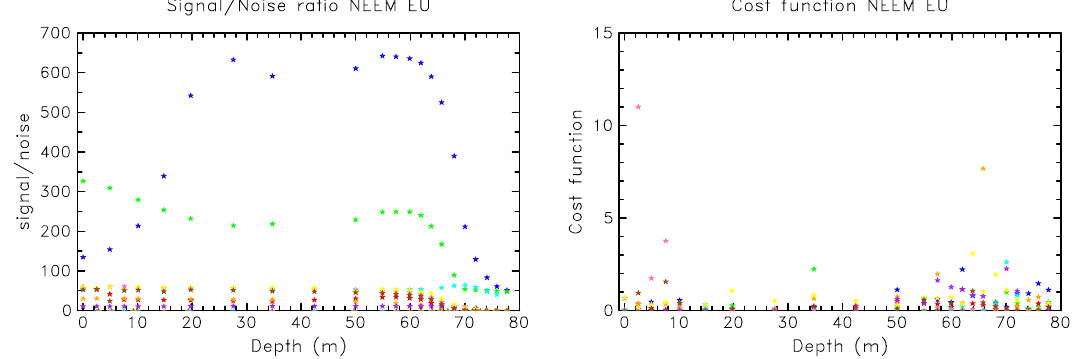
Fig. 4. Signal-to-noise ratio of firn air measurements (left) and data weights in the minimised cost function (right) at NEEM (EU hole) for CO 2 (blue), CH 4 (green), SF 6 (red), HFC-134a (orange), CH 3 CCl 3 (violet), 14 CO 2 (turquoise), CFC-11 (pink), CFC-12 (yellow) and CFC-113 (brown). The cost function distribution versus depth is presented for the reference case (one colour per